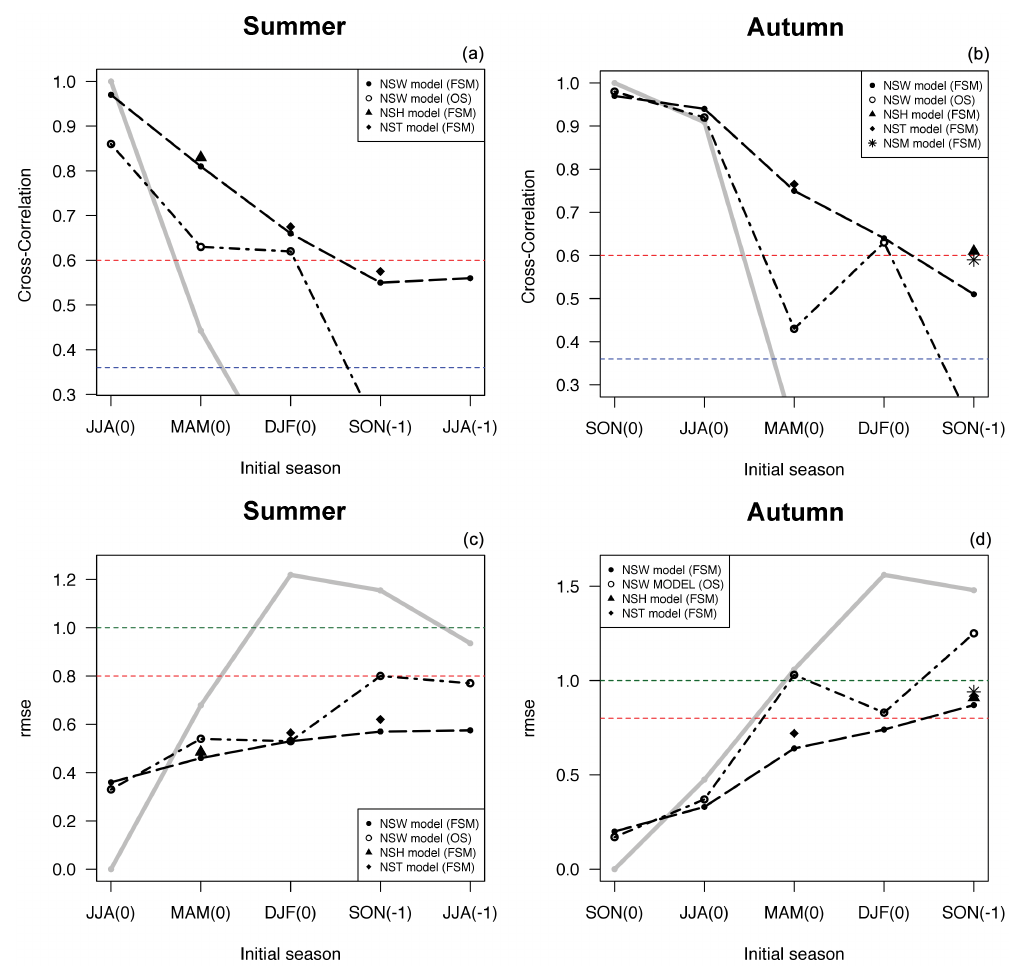
Figure 2. Seasonal cross-correlation of the Niño3.4 Index hindcast with the NSW model in (a) summer and (b) autumn. Different versions of the stochastic T-model: the NSW model under FSM scheme (filled circle), the NSW model under OS scheme (empty circle), the NSH model under FSM scheme (triangle), the NST model under FSM scheme (diamond), and the NWM model under FSM scheme (asterisk). On the background, the solid gray line represents the cross-correlation of the hindcast produced assuming the Niño3.4 Index persistence. The blue straight dashed line indicates the statistical significance threshold at 95% confidence level. The red dashed straight line represents an arbitrary threshold for the useful forecast as proposed by Hollingsworth et al. (1980). Panels (c) and (d) shown the seasonal cross-RMSE of the Niño3.4 Index hindcasted with the NSW model and others versions of the stochastic T-model in summer and autumn, respectively. On the background, the solid gray line represents the cross-RMSE of the hindcast produced assuming the Niño3.4 Index persistence. The blue straight dashed line indicates the statistical significance threshold at 95% confidence level. Finally, The red dashed straight line represents an arbitrary threshold for the useful forecast as derived by Hollingsworth et al.